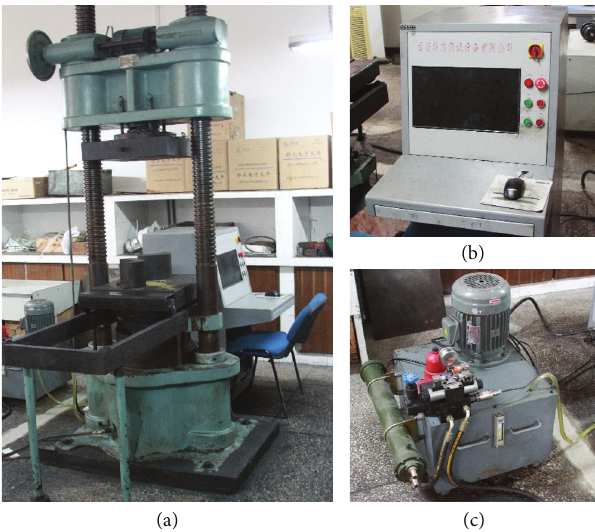
Figure 8: The complete load-strain curves of spoil samples: (a) single gradation; (b) Talbot’s